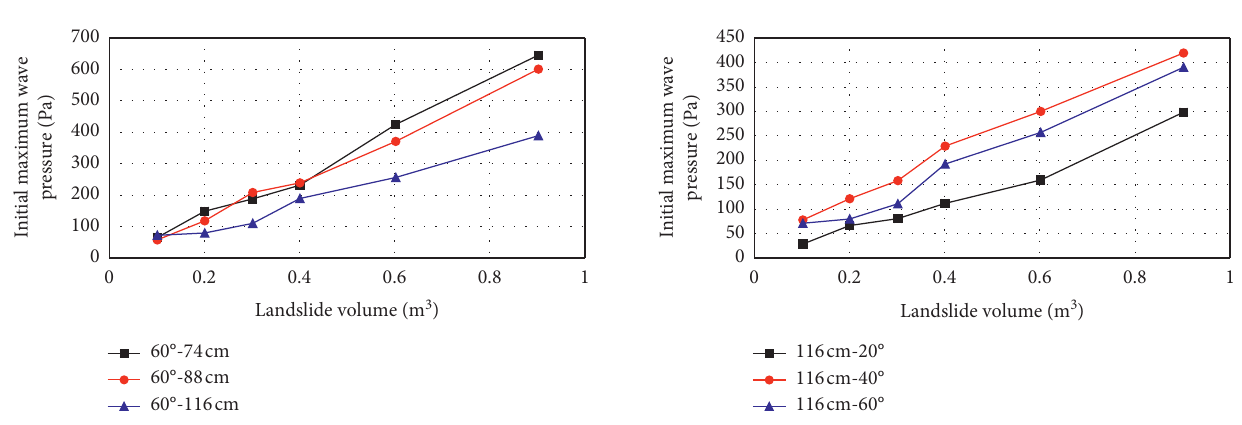
Figure 13: Variation of initial maximum wave pressure with landslide volume at three water depths (at 60 ° ).